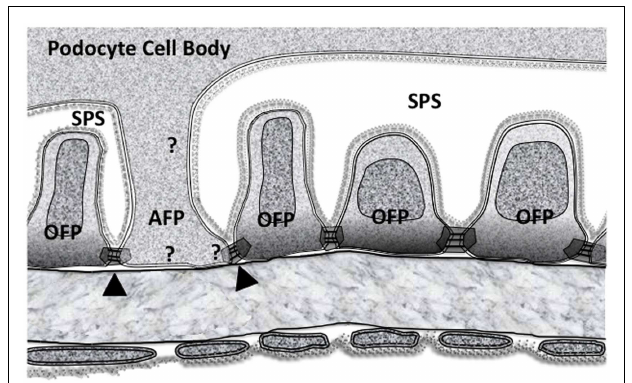
FIGURE 4 |The subpodocyte space (SPS) GFB showing the disposition of membrane domains in foot processes as in Figure 2 . Ordinary foot processes (OFP) have signaling networks that are well defined.The less frequent anchoring foot processes (AFP) could have some of the features of (OFP) but must have some differences based upon their altered response to increased perfusion pressure. Arrowheads mark the possible asymmetric slit diaphragm between OFP and AFP. Question marks show the possibility of differences in all three membrane associated